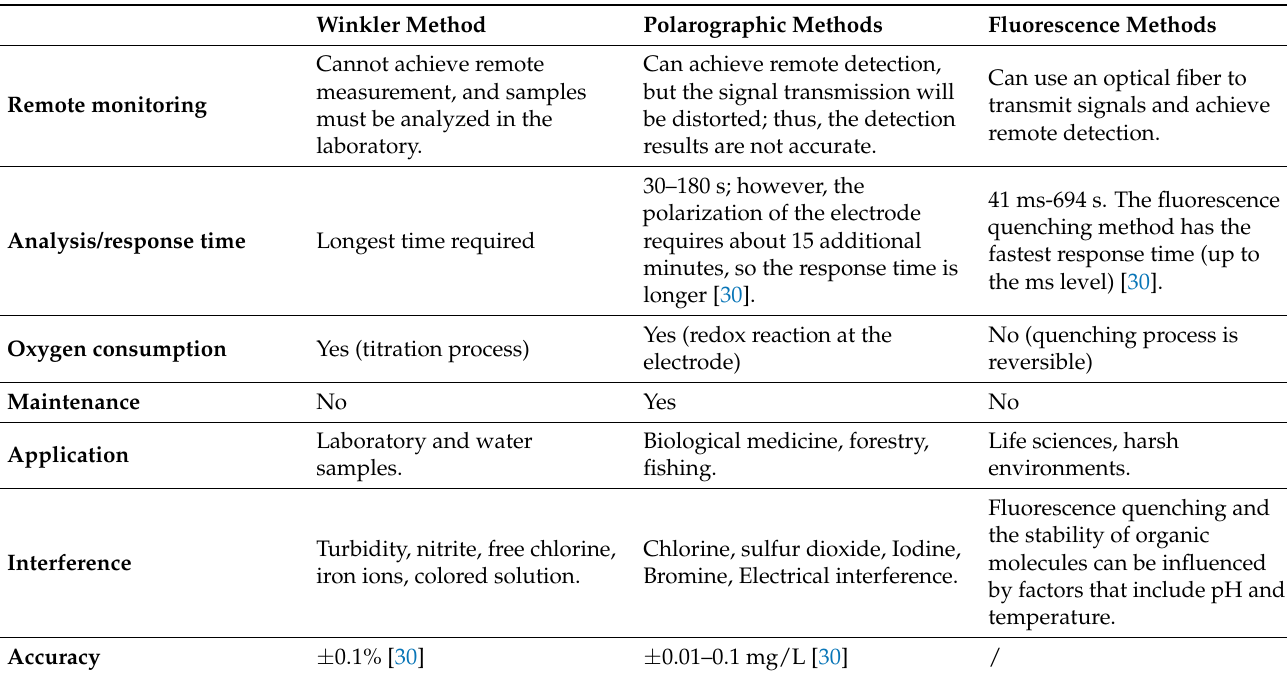
Table 2. Summary comparison between the three main classical DO detection